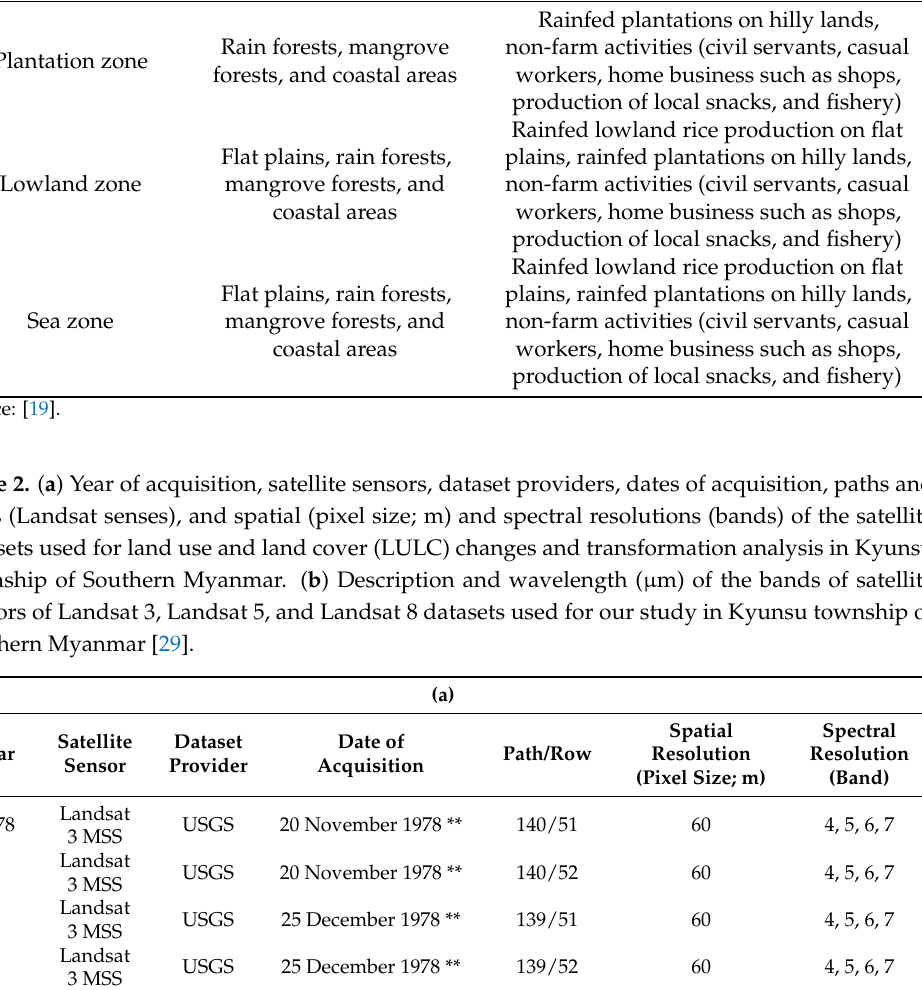
Table 1. Geographical features and livelihood strategies of three agroecological zones of Kyunsu township in Southern Myanmar. Agroecological Geographical Livelihood Strategies Zones Features Rainfed plantations on hilly lands, Rain forests, mangrove non-farm activities (civil servants, casual forests, and coastal areas workers, home business such as shops,